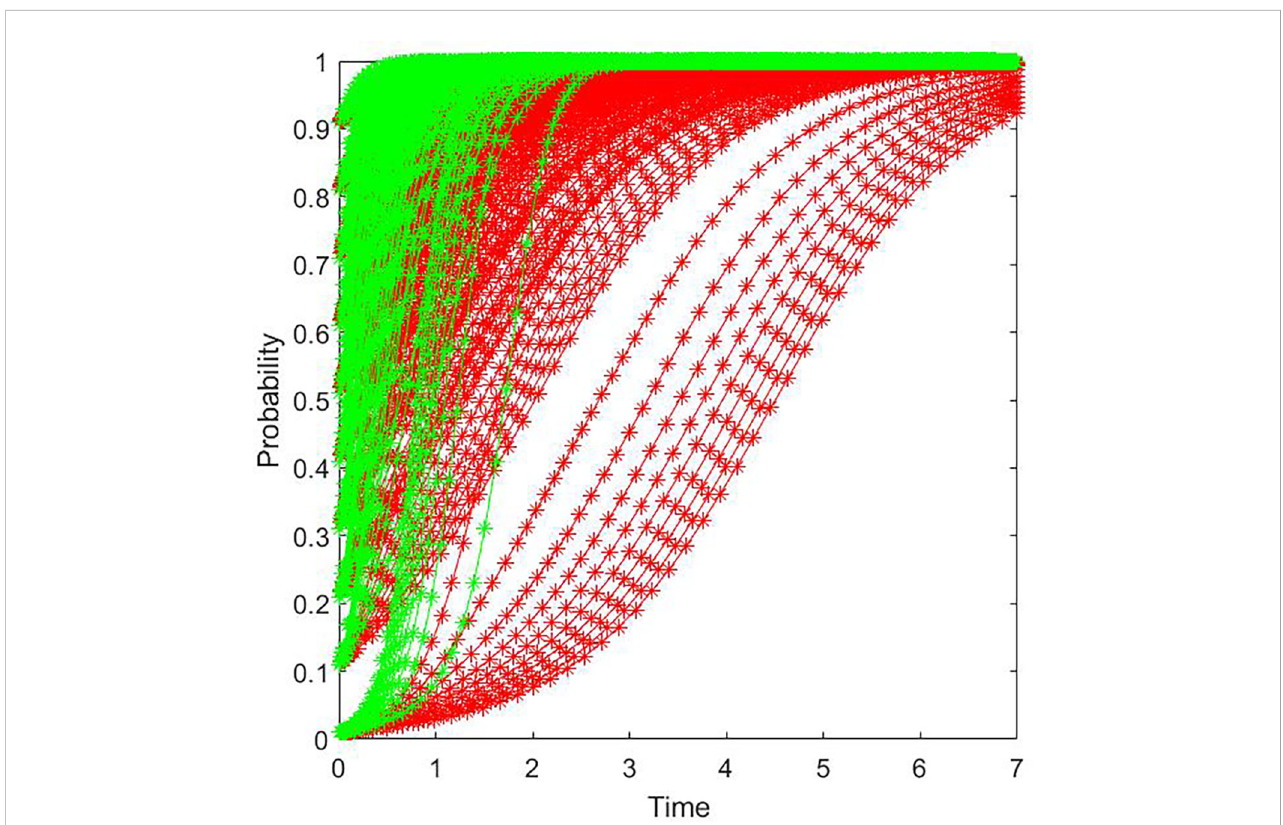
FIGURE 3 Evolutionary path diagram of the two-party game system with different initial probabilities (Scenario 1). (Note: The red curve represents the government and the green curve represents shipping